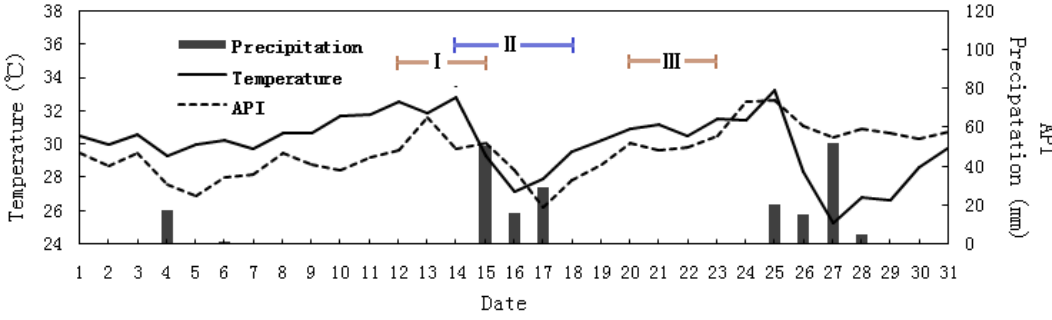
Figure 2. The measured temperature, precipitation, and air pollution index (API) at Guangzhou station in July 2006 (period I: July 12-15; period II: July 14-18; period III: July 20-23).